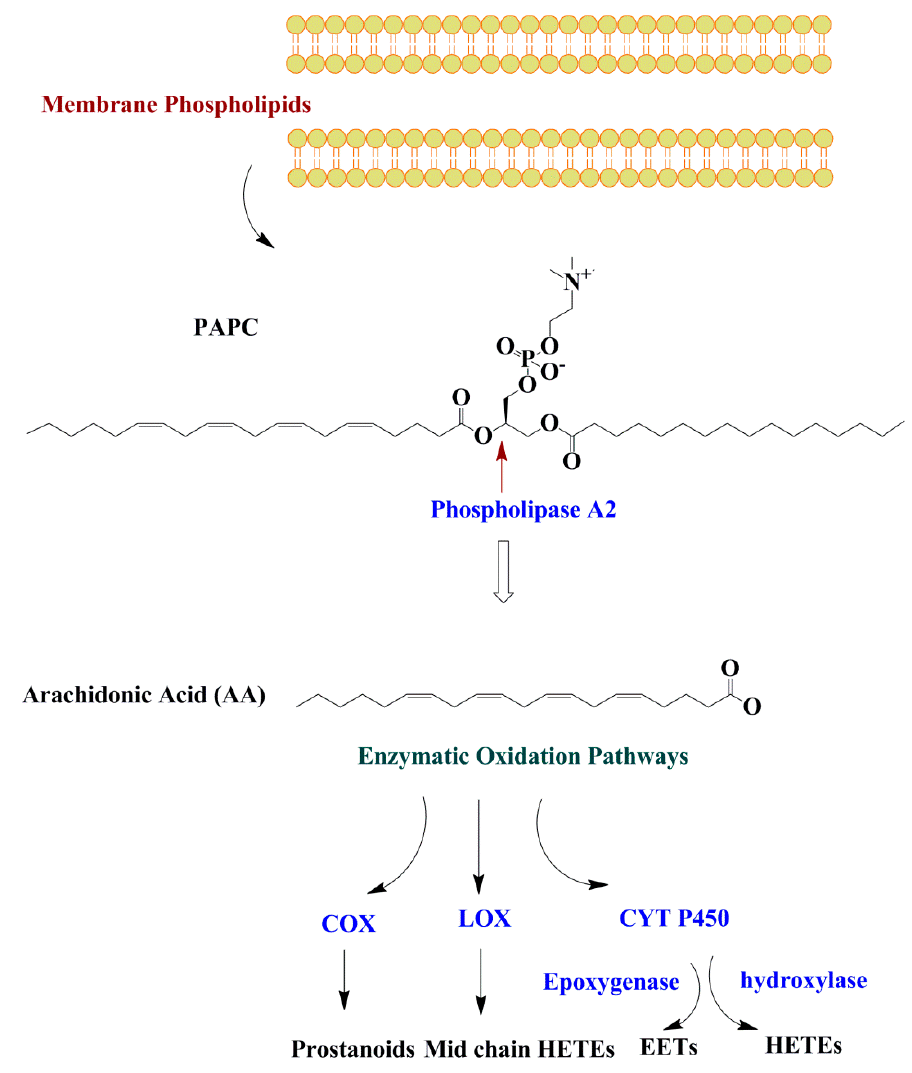
Figure 3. Enzymatic oxidation of membrane phospholipids. Fatty acids are released from the membrane PL by the phospholipase A2 enzyme and may undergo oxidation through three oxidation pathways including COX, LOX, and CYT P450. Abbreviations: COX, cyclooxygenase; LOX, lipoxygenase; CTY P450, cytochrome P450; HETE; hydroxyeicosatetraenoic acids; EET, epoxyeicosatrienoic acids.